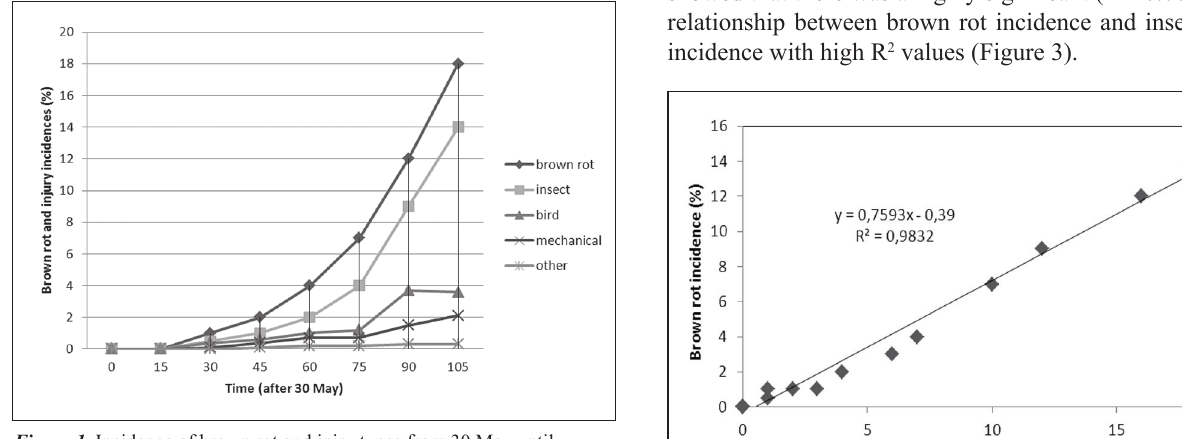
Figure 1. Incidence of brown rot and injry types from 30 May until September (Eperjeske, Hungary, 2014)